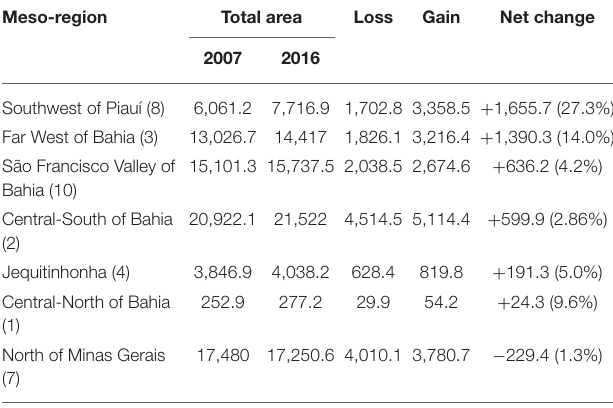
TABLE 2 | Changes in the area (km 2 ) of tropical dry forests per meso-region from 2007 to 2016. Meso-region